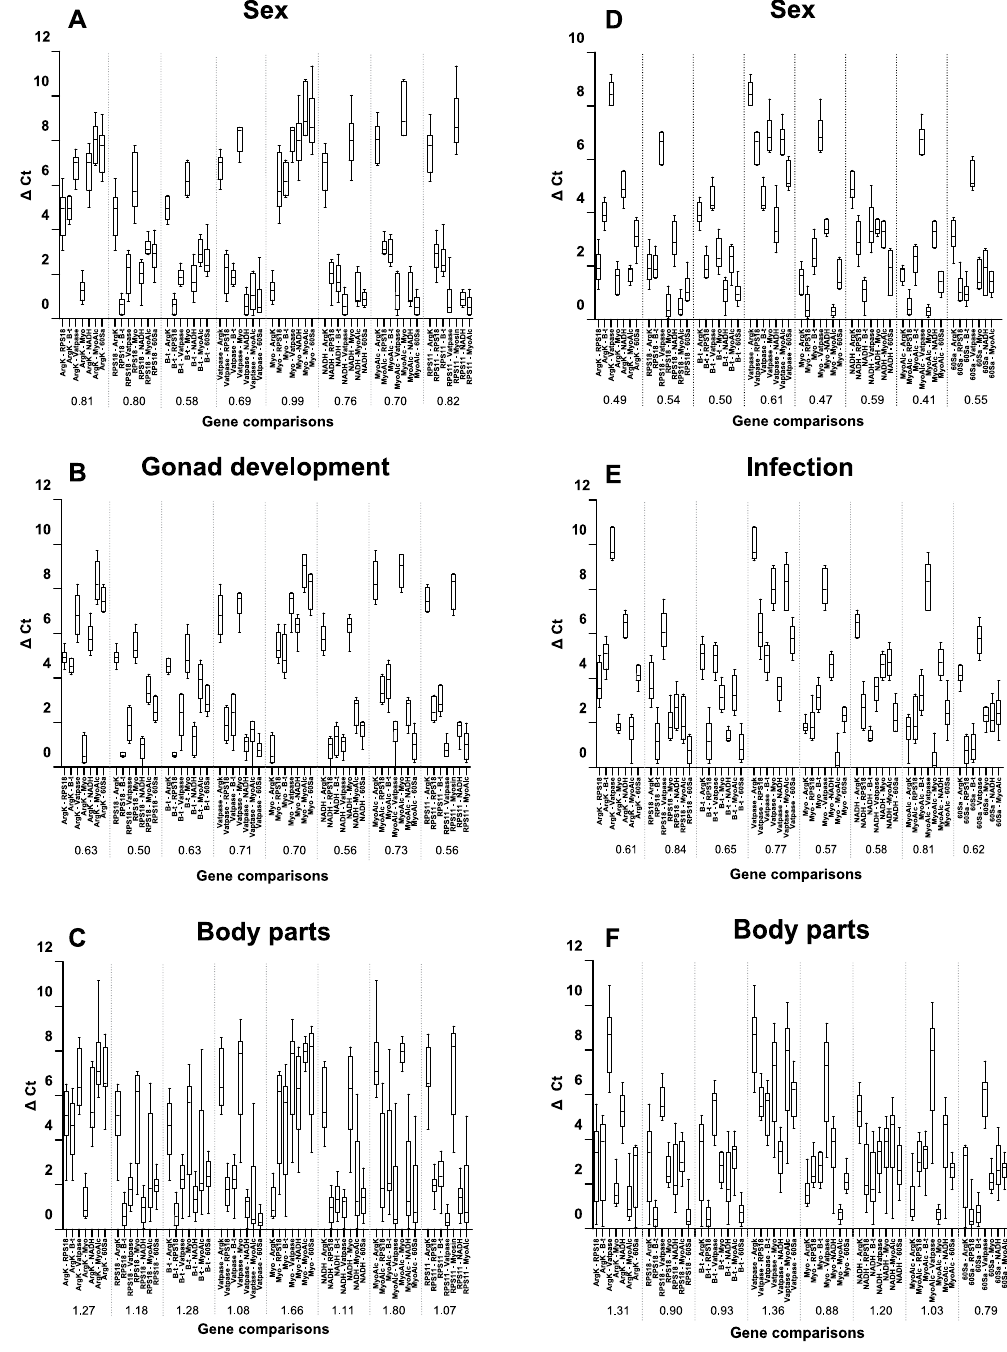
Figure 6. Δ C T approach to reference gene selection in Cicindela campestris ( A–C ) and Calomera littoalis ( D – F ) for each condition tested. Δ C T values are indicated as medians (horizontal lines), 25 th to 75 th percentile (boxes) and ranges (whiskers). Values in x-axis indicate the means of the standard deviations for each gene comparison. The lowest values correspond to the highest